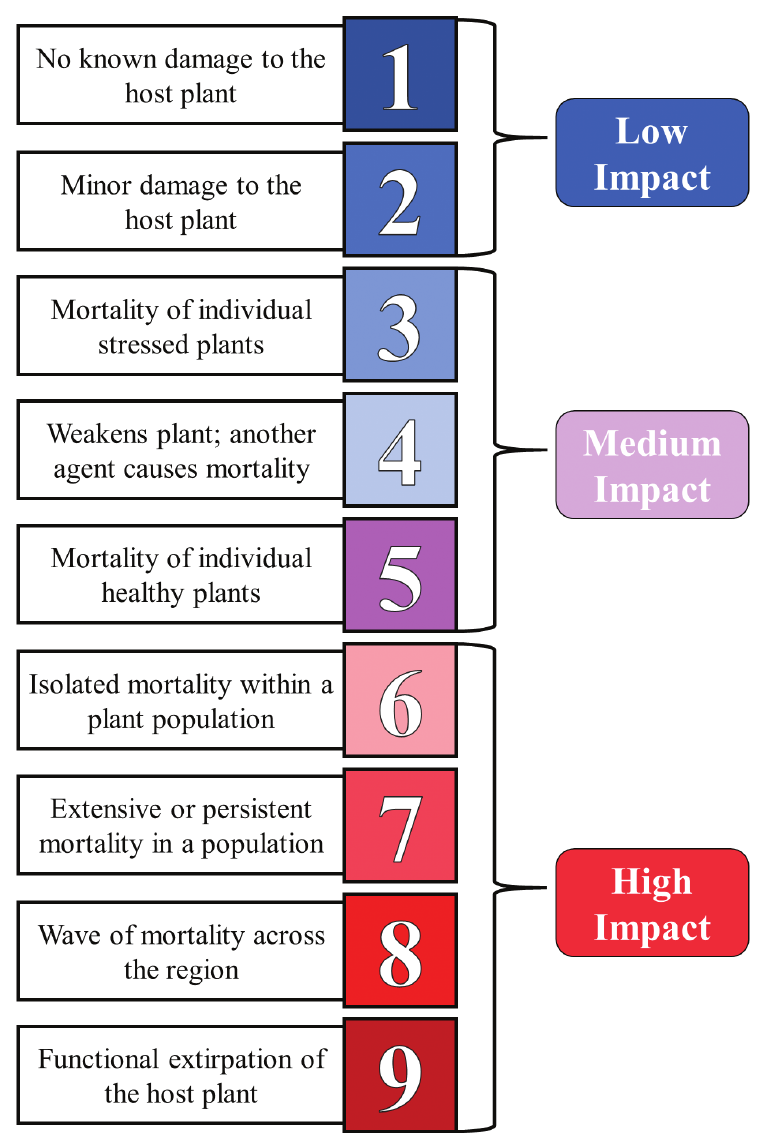
Figure 1. Impact scoring system (1–9) established by the HIWG for non-native, phytophagous insects , where 1 indicates no damage and 9 indicates severe damage (also found in Mech et al. 2019a).